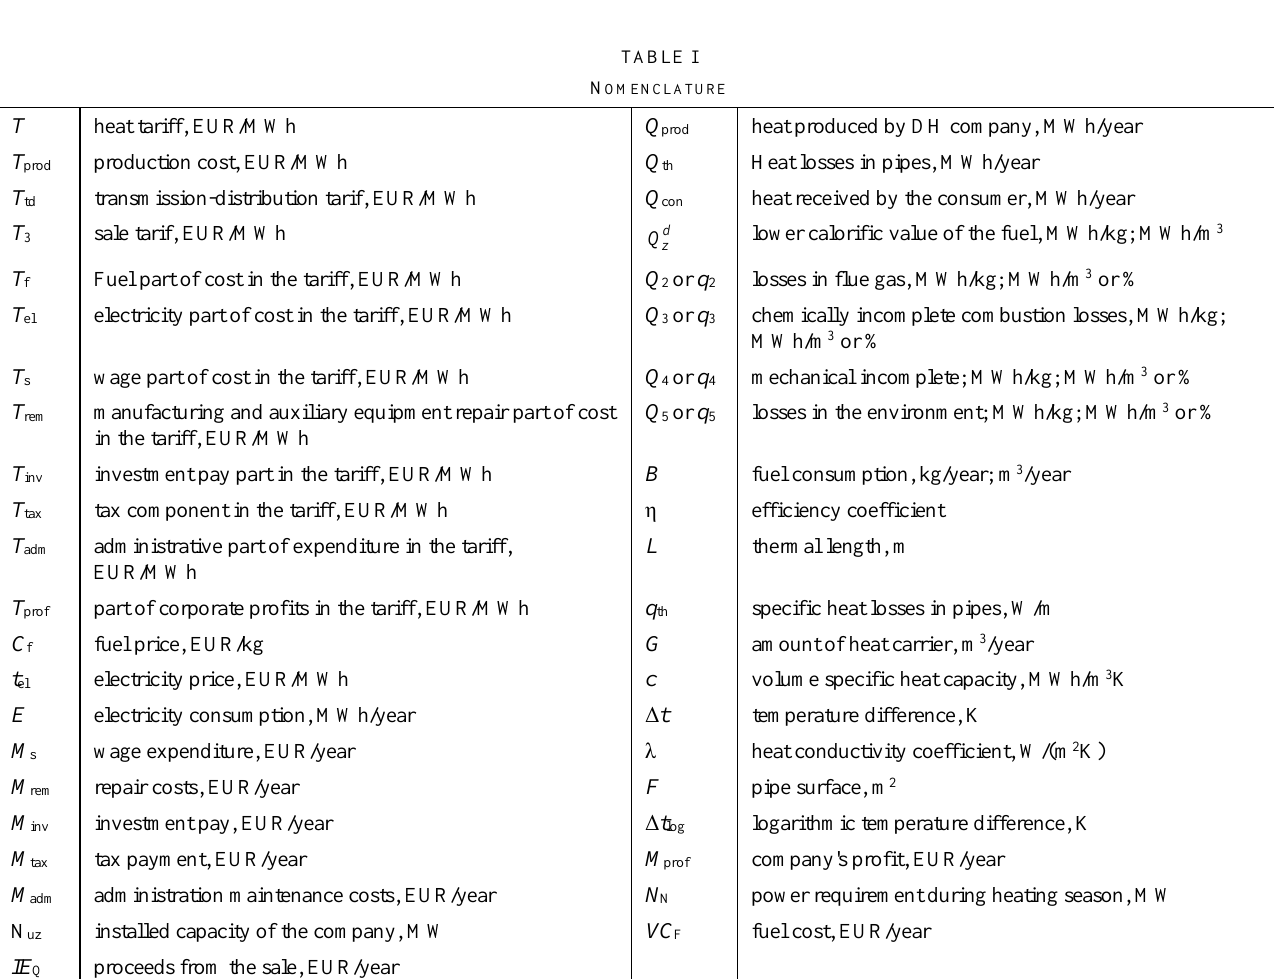
Fig. 1. District heating system